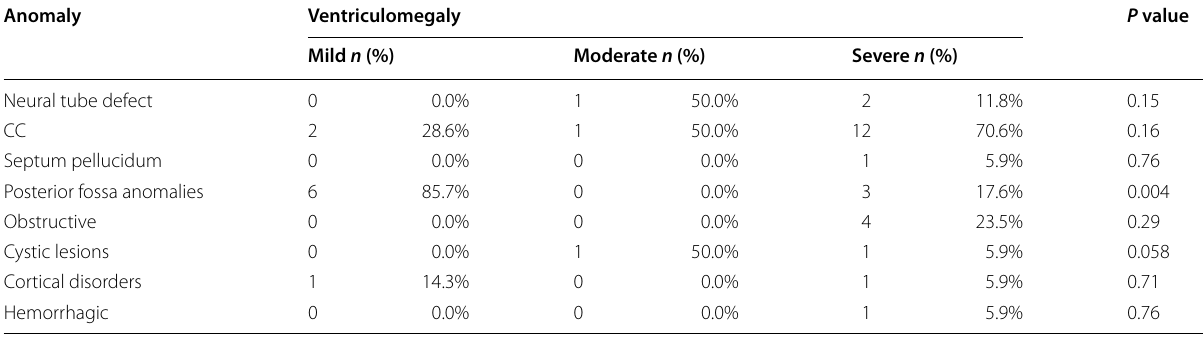
Table 3 Distribution of anomalies in relation to severity of ventriculomegaly